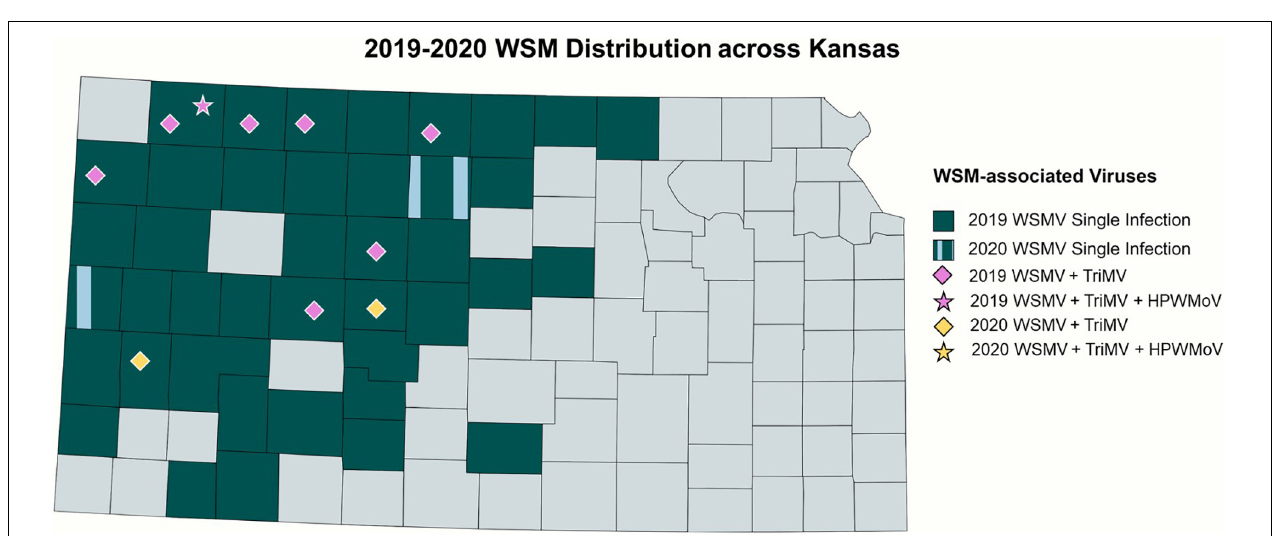
FIGURE 2 | Collection sites of the wheat samples surveyed in 2019 and 2020. Symptomatic and asymptomatic leaf samples were screened for WSM-associated viruses. The survey covered 54 counties from central and western Kansas and two eastern counties.